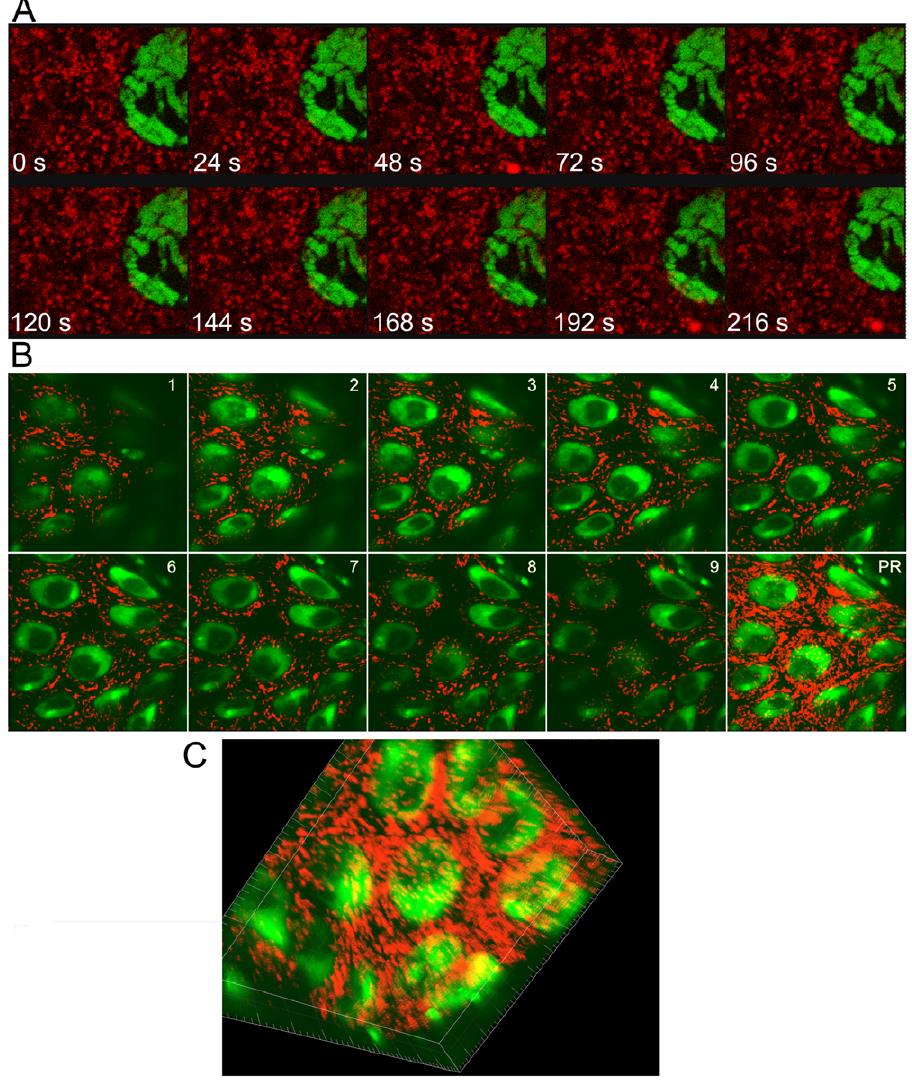
Figure 5. Use of Tim17b-DsRed fluorescent reporter for time-lapse microscopy of mitochondria, 3D reconstruction of mitochondrial network and mitochondrial proteins dynamics assay. A. Time-lapse microscopy of live Drosophila tissue. Tim17b-DsRed is shown in red color. DNA is detected using Draq5 dye (green). B–C. 3D-mitochondrial network within mid-intestinal cells. 1–9 represent individual confocal sections. PR – X-Y projection. C. 3D reconstruction of the mitochondrial network is presented. Tim17b-DsRed is shown in red color. DNA is detected using TOTO3 dye (green).